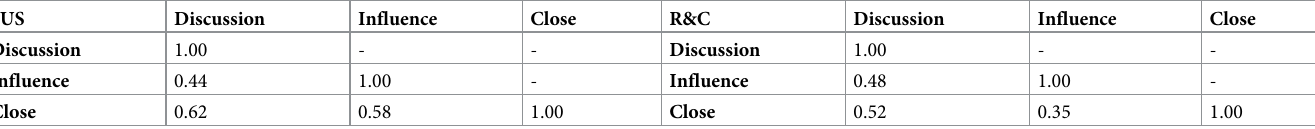
Table 4. Graph correlation indices between discussion, influence and close networks between participants for both Shape Up Somerville (SUS) and Romp & Chomp (R&C).